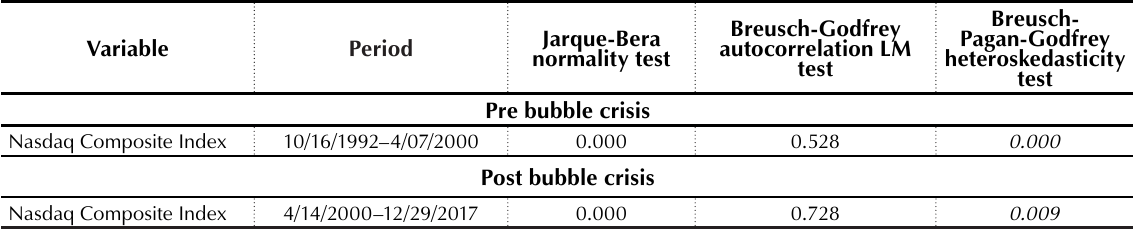
Table 6. Pre and post crisis robustness